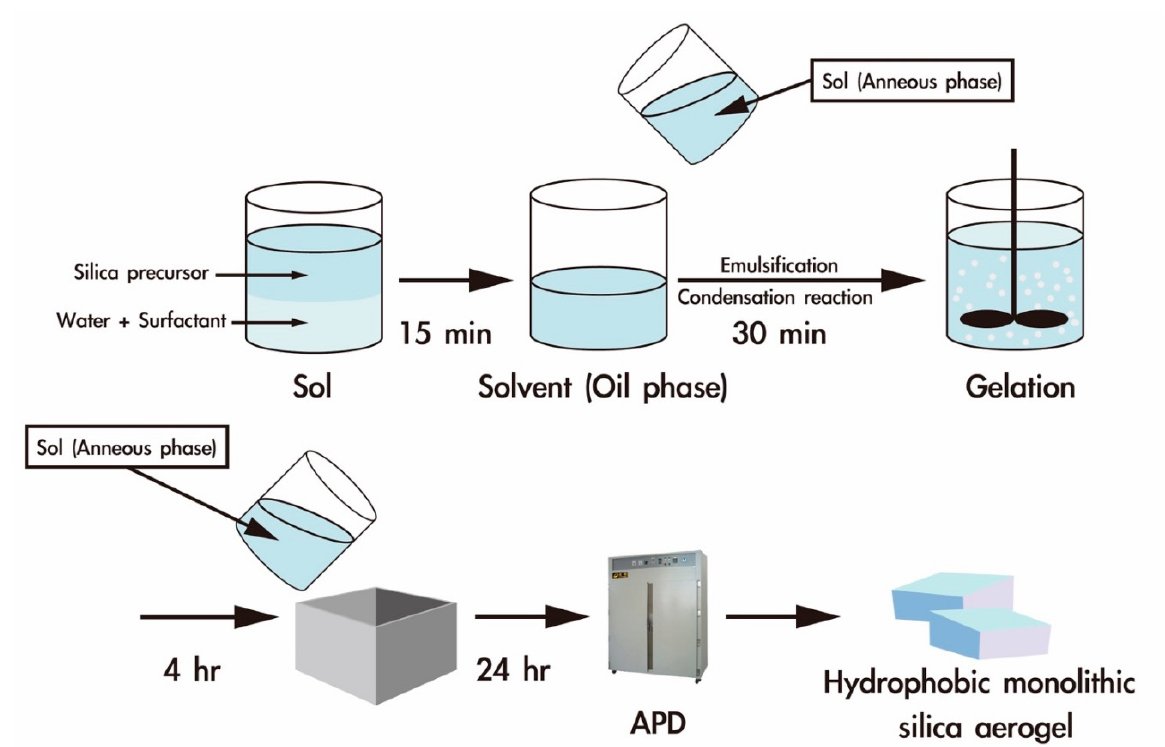
Figure 1. Schematic description of the formation of the aerogel porous board via the emulsion method combined with APD.